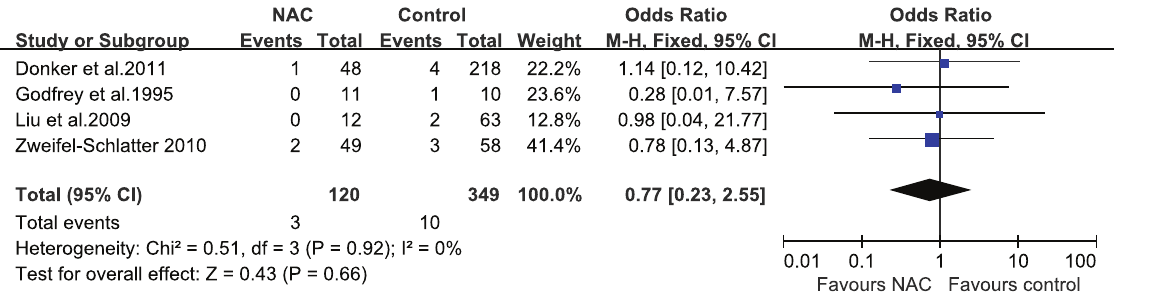
Figure 4. Pooled results of seromas in patients treated with NAC. The size of the solid squares is inversely proportional to the variance of the study estimate. The diamond represents the fixed effects odds ratio and 95% confidence interval.